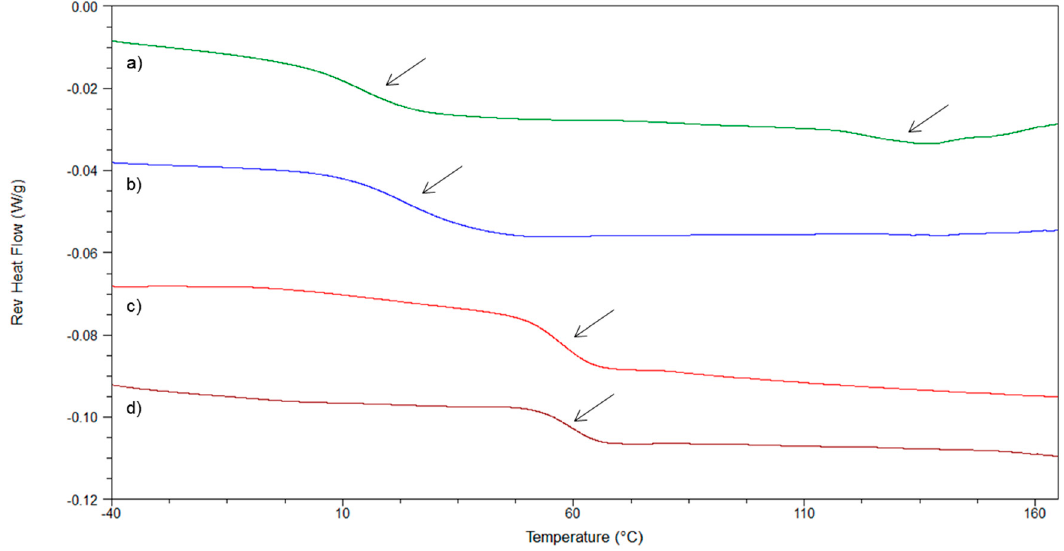
Figure 10. Reverse heat flow signals of NAP/PVA 40:60 ( w / w ) produced by ( a ) (green-solid line) film casting at RT; ( b ) (blue-solid line) film casting at low pressure; ( c ) (red-solid line) atomization device; and ( d ) (brown-solid line) spray dryer.